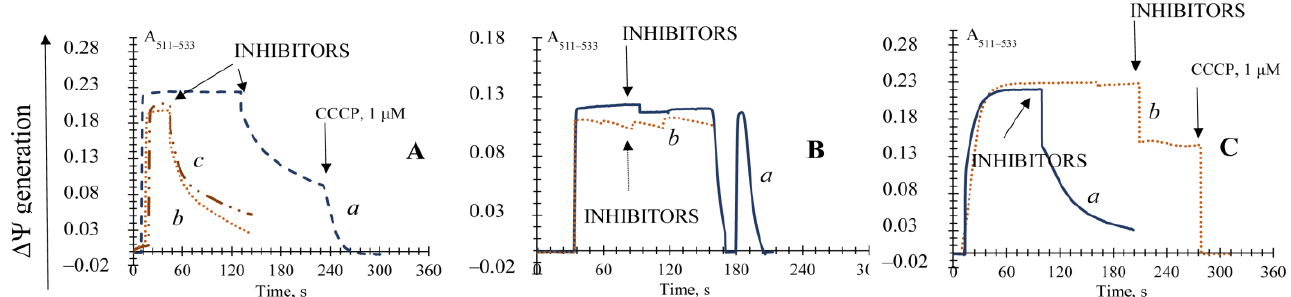
Figure 5. Effects of Mg 2+ ions, polyamines, and the GSH on the induction of the non-specific permeability transition in the E. magnusii mitochondria promoted by the application of the antioxidant enzyme inhibitors. Panel ( A ): the basic incubation medium also contained 5 mM Mg 2+ (trace a), 40 or 100 μМ spermidine (trace b and c, respectively), or 5 mM GSH. The ΔΨ was generated by the application of the substrate system (pyruvate + malate) (Panel ( B )); α-ketoglutarate (Panel ( C )); trace a—control; trace b—5 mM GSH was incubated with the 28 mitochondria and applied before the inhibitors’ addition. Addition of the inhibitors mixture (4 mM DDC and 4 mM ATZ) is indicated by the dashed arrows.